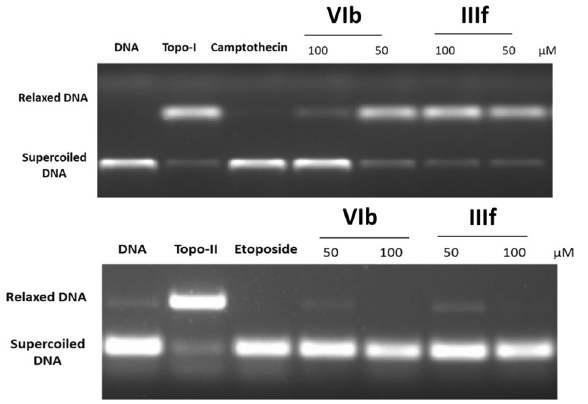
Figure 10. Recombinant Topo I & II inhibitory activities of ( IIIf ) and ( VIb ). DNA bands were visualized by transillumination with UV light and quantitated using AlphaImagerTM (http:// genet ictec hnolo giesi nc. com, Alpha Innotech Corporation).